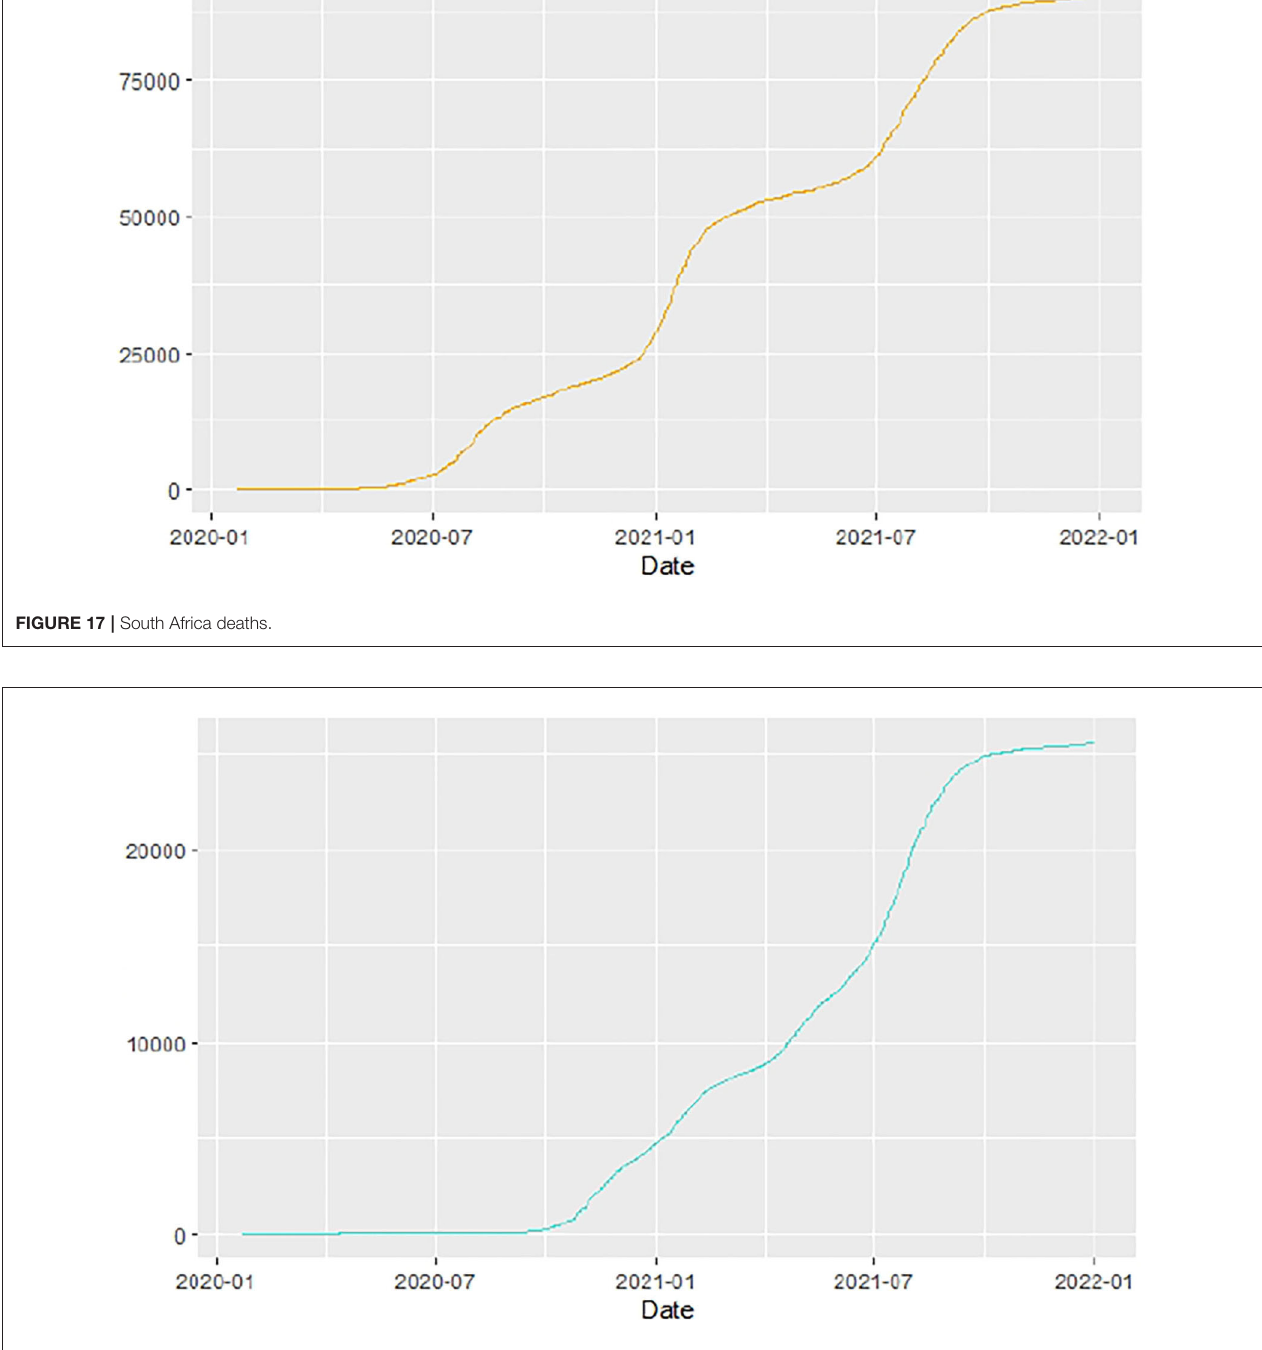
FIGURE 18 | Tunisia